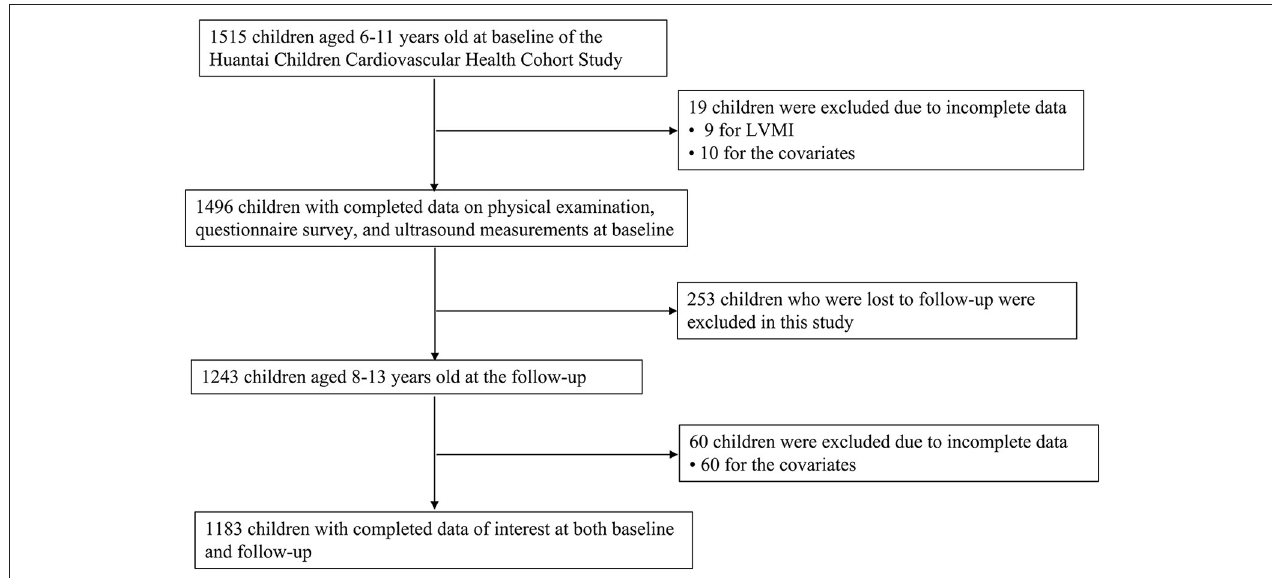
FIGURE 1 | Flowchart of inclusion/exclusion of